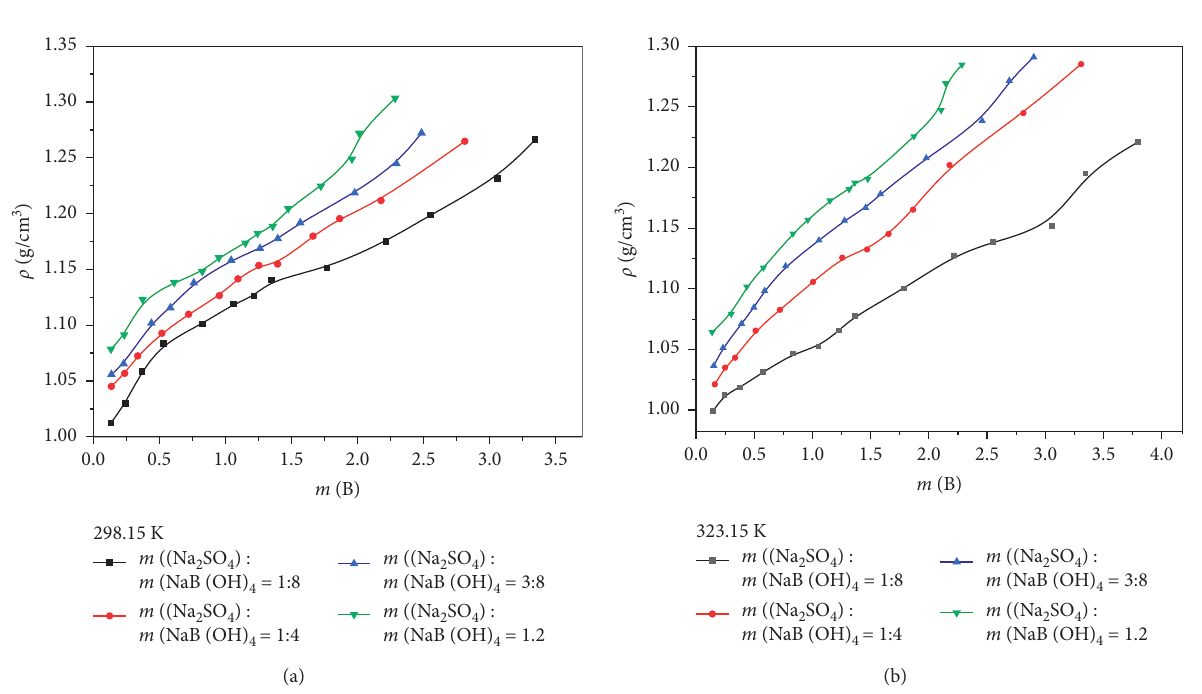
Figure 2: The density of mixed solution of the NaBO 2 –Na 2 SO 4 –H 2 O system. (a) 298.15K. (b) 323.15K. Black line, m (Na 2 SO 4 ): m (NaB(OH) 4 ) � 1 :8; red line, m (Na 2 SO 4 ): m (NaB(OH) 4 ) � 1: 4; blue line, m (Na 2 SO 4 ): m (NaB(OH) 4 ) � 3 :8; green line, m (Na 2 SO 4 ): m (NaB(OH) 4 ) � 1